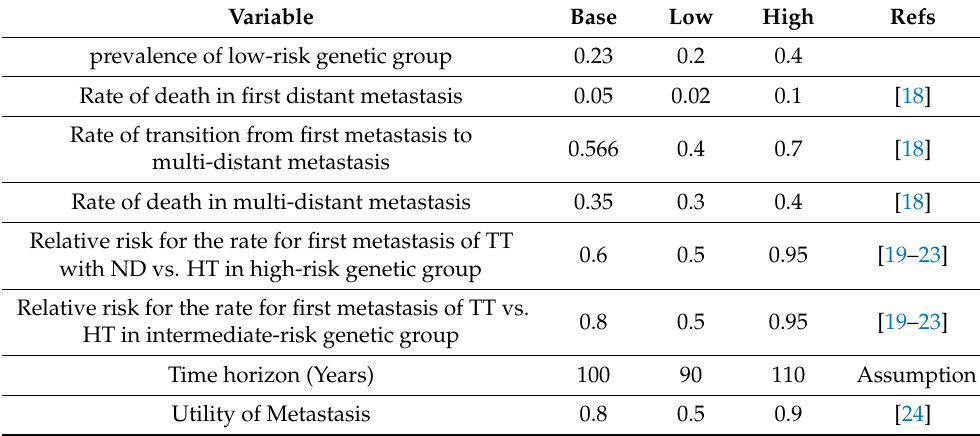
Table 1. Cont. Variable Base Low High Refs prevalence of low-risk genetic group 0.23 0.2 0.4 Rate of death in first distant metastasis 0.05 0.02 0.1 [18] Rate of transition from first metastasis to 0.566 0.4 0.7 multi-distant metastasis Rate of death in multi-distant metastasis 0.35